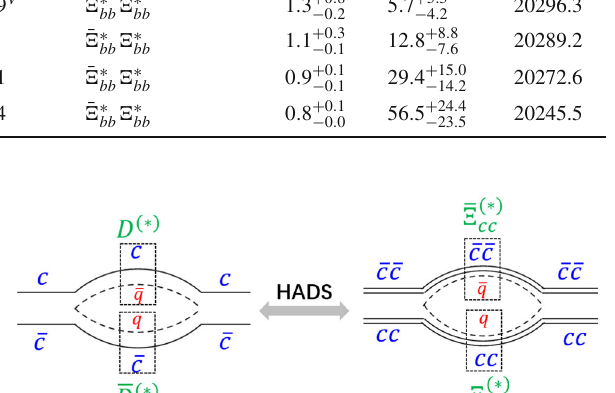
quark diquark symmetry (HADS). The contact-range poten- tials of these systems respecting heavy quark spin symmetry (HQSS) are constrained to two couplings at the leading order, C a and C b . Assuming that X ( 3872 ) is a J PC = 1 ++